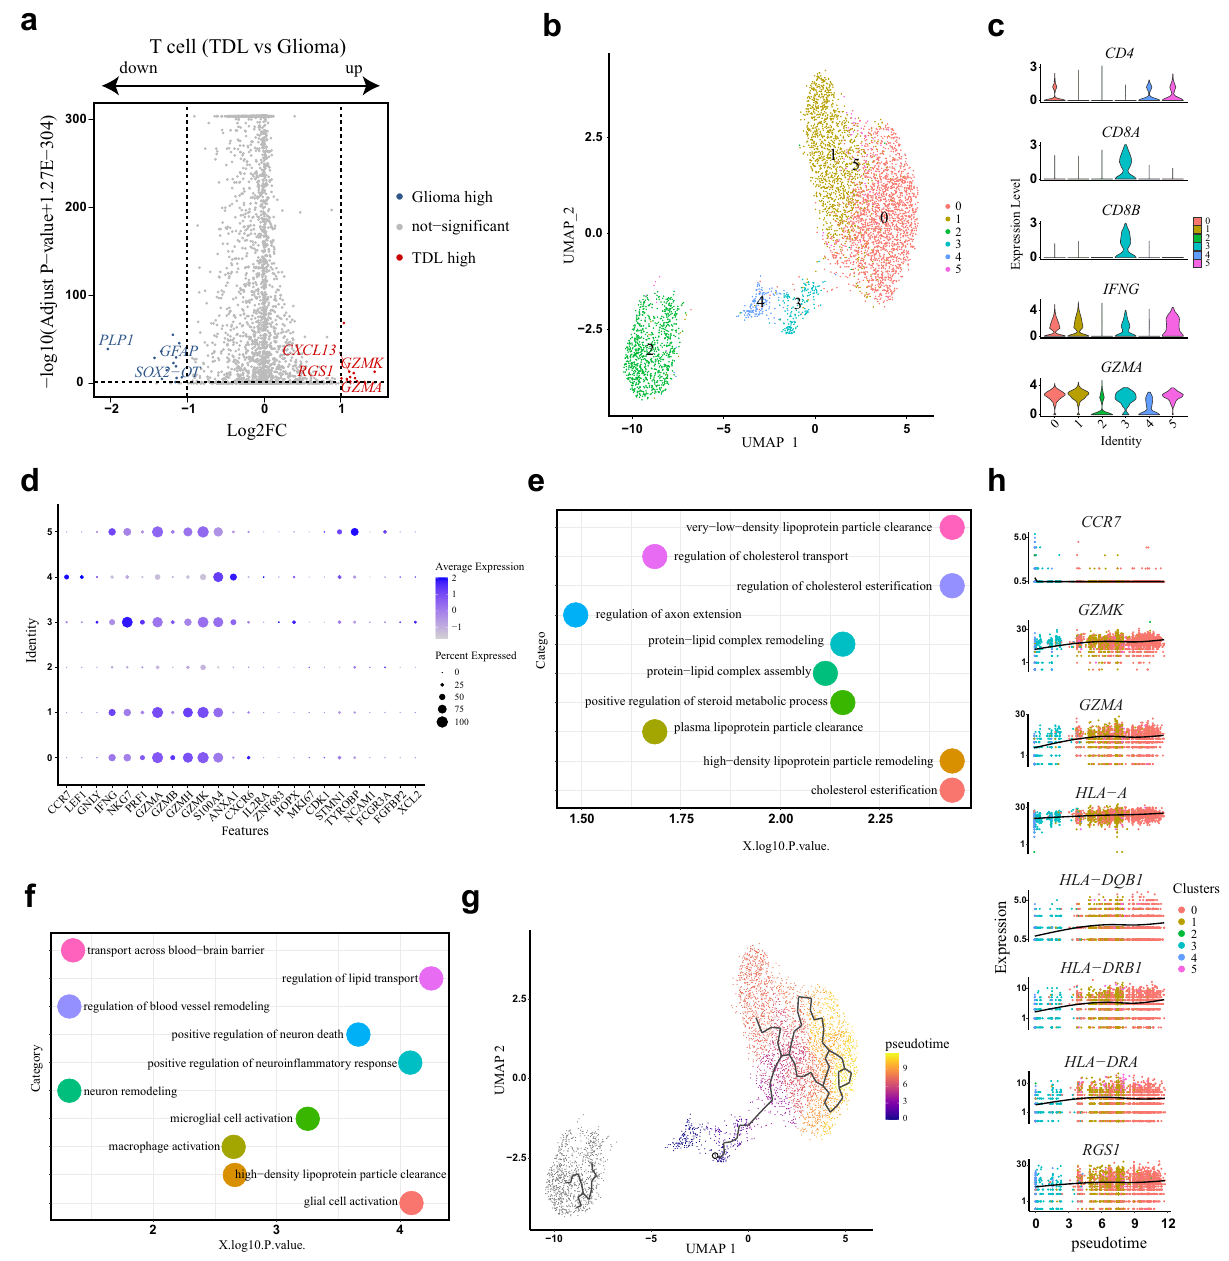
Fig. 4 Transcriptomic difference of T cells between TDL and glioma and reclustering of T cells in TDL. a Volcano plot of differentially expressed genes (DEGs) that are upregulated (red) or downregulated (blue) in T cells of TDL by comparing to T cells of glioma. b UMAP plot of T cells from TDL after reclustering revealed 6 subclusters (C0, C1, C2, C3, C4, and C5). c Violin plots showing the speci fi c expression distribution of selected genes related to T-cell subclusters. d Dotplot showing the characteristics of T-cell subclusters. e Dotplot of GO analysis (biological process) based on top 20 markers in C2. f Dotplot of GO analysis (biological process) based on top 20 markers in C5. g The pseudotime trajectory predicted by Monocle 3 and displayed by UMAP plot. Cells were ordered and colored by pseudotime in a gradient from purple to yellow. h The dynamic changes of expression level of selected genes along with pseudotime progression. TDL tumefactive demyelinating lesion, DEGs differentially expressed genes, FC fold change, GO Gene Ontology, UMAP Uniform Manifold Approximation and